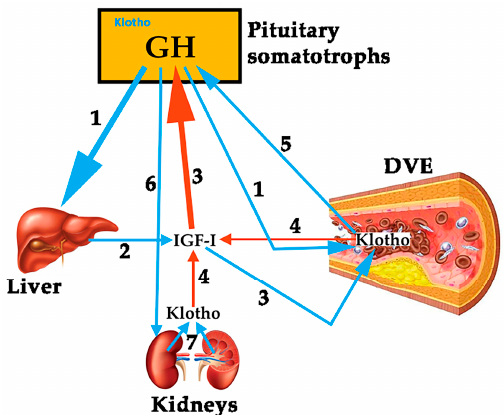
Figure 2. Schematic representation about the possible relationships between GH, Insulin growth factor (IGF-I) and Klotho, and its actions on the vascular endothelium. ( 1 ) Pituitary GH induces the hepatic expression of IGF-I ( 2 ) and acts on the repair of the damaged vascular endothelium (DVE), although it is also possible that the hormone enhances the production of Klotho by this damaged tissue. ( 3 ) Besides, its inhibitory effects on pituitary GH release, IGF-I also contributes to repair DVE, and, as in